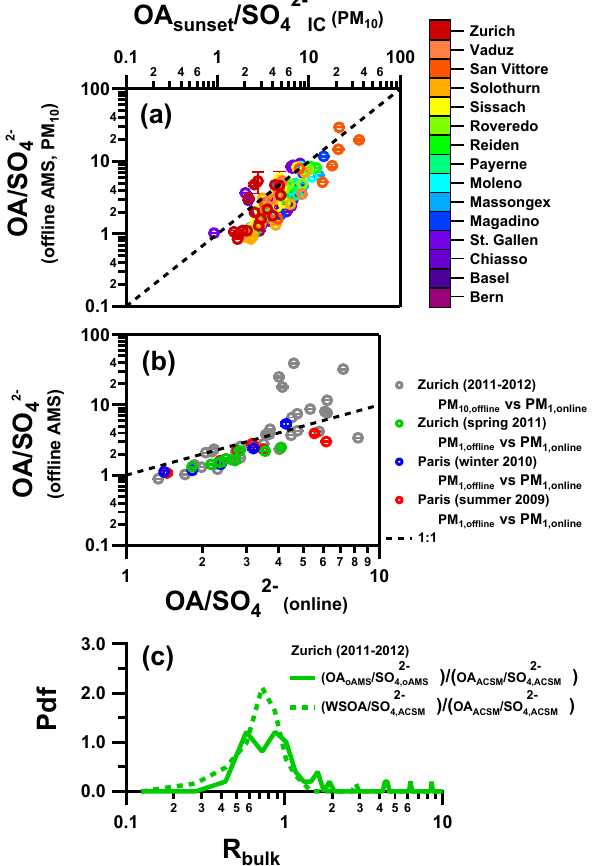
Figure 3. Estimated recoveries of organic compounds based on the comparison of OA / SO 2 − ratios using the offline AMS method to 4 reference measurements for different days. The error bars represent the variability of the offline OA / SO 2 − ratio within a sample and 4 were obtained from different runs during the same measurement of the same sample. (a) The reference OA / SO 2 − ratio is obtained 4 by OC filter measurements (Sunset OC / EC analyzer) scaled to OA using OM / OC values from the HR offline AMS data and SO 2 − 4 from IC. (b) OA / SO 2 − ratios from online measurements were used 4 as reference values. For both Paris campaigns and the Zurich spring campaign, the online measurements were conducted using HR-ToF- AMS and for the yearly cycle in Zurich by a quadrupole ACSM. (c) For Zurich (2011–2012), probability density functions of R bulk are presented both using the offline AMS measurements as well as using WSOC from the Sunset OC / EC Analyzer (in combination with OM / OC ratios from offline AMS).